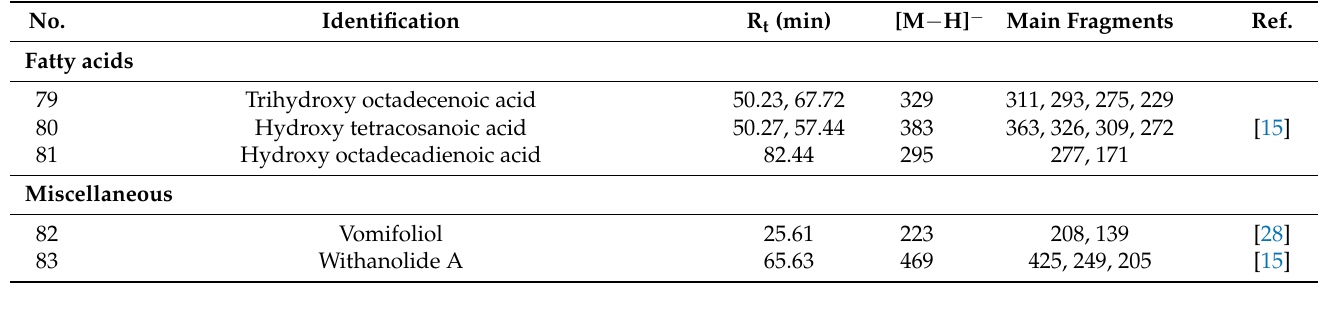
cinols (FPs), polyphenolics (Hydrolyzable tannins, phenolic acids, flavanone glycoside,